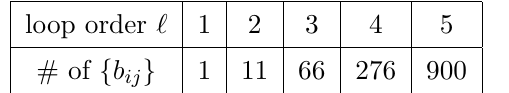
Table 2 . The number of di(cid:11)erent harmonic structures (modulo permutation of the external points) speci(cid:12)ed by f b ij g in the set of all ‘ -loop correlators assuming that the saturation bound in (2.15) is (cid:20) = (cid:20) min